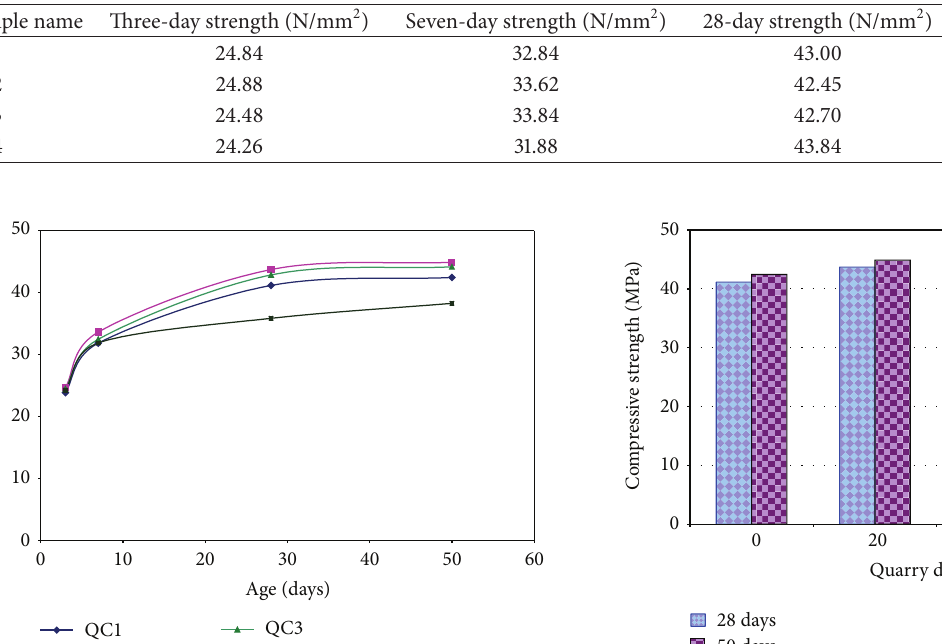
Table 9: Compressive strength test result for QF series.